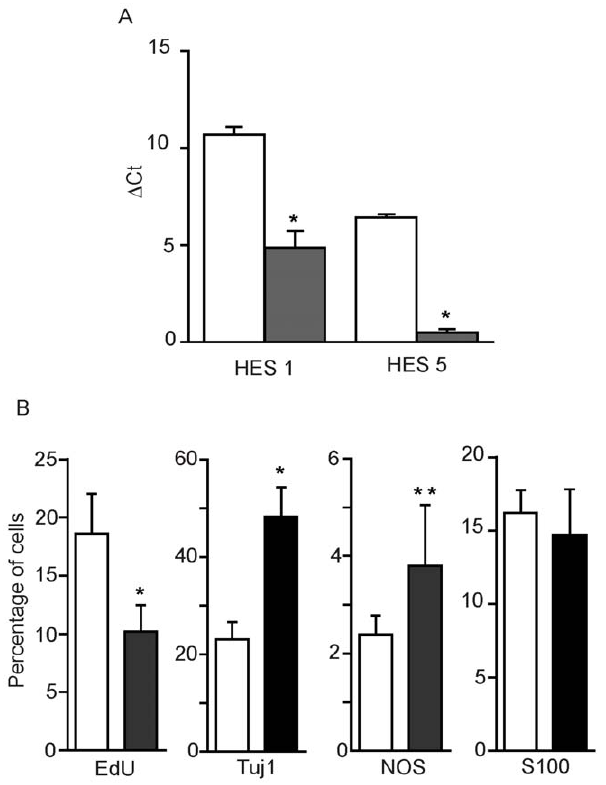
Figure 5. Effects of DAPT-mediated c -secretase inhibition on cell proliferation and expression of neuronal and glial markers by mouse neurosphere cells. After 2 weeks culture mouse neuro- spheres were cultured for a further 96 h in the presence of 20 m M DAPT (shaded columns) or DMSO solvent control (clear columns). A: Levels of Hes1 and Hes5 mRNA determined by q-PCR. Columns show the D C t values, normalised to b -actin levels ( 6 SEM, means of 3 individual experiments). B: Expression of neuronal and glial markers. Cells dissociated from the neurospheres were allowed to adhere to Permanox slides before fixation and staining for EdU, Tuj1, NOS and S100. Nuclei were counter-stained with DAPI. Fluorescent cells were counted in 5 random optical fields in each chamber using a 40 x oil objective. Error bars are 6 SEM, (values from 3–5 experiments). A two- tailed t-test was performed for differences between open and closed columns for each marker. *p , 0.01.